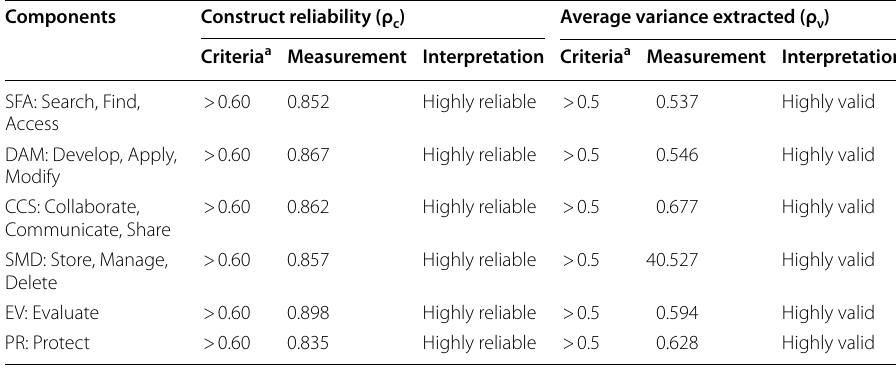
a Muthén and Muthén (2012), Bandalos (2018)